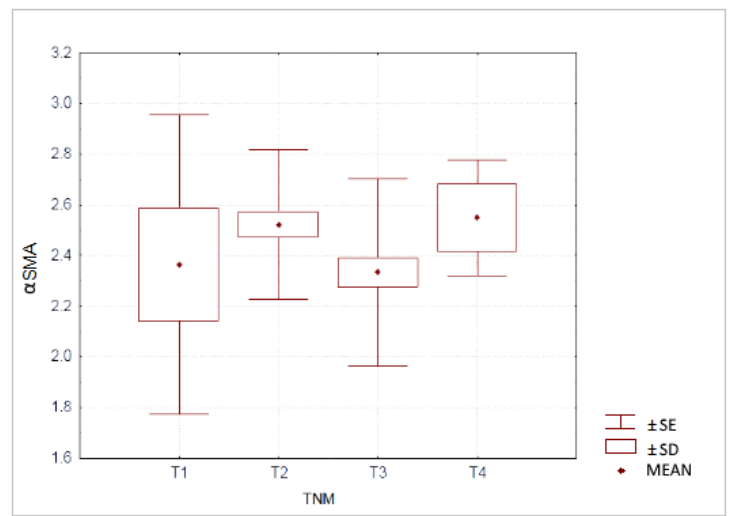
Figure 4. Expression of α SMA in pancreatic ductal adenocarcinoma according to TNM classification.